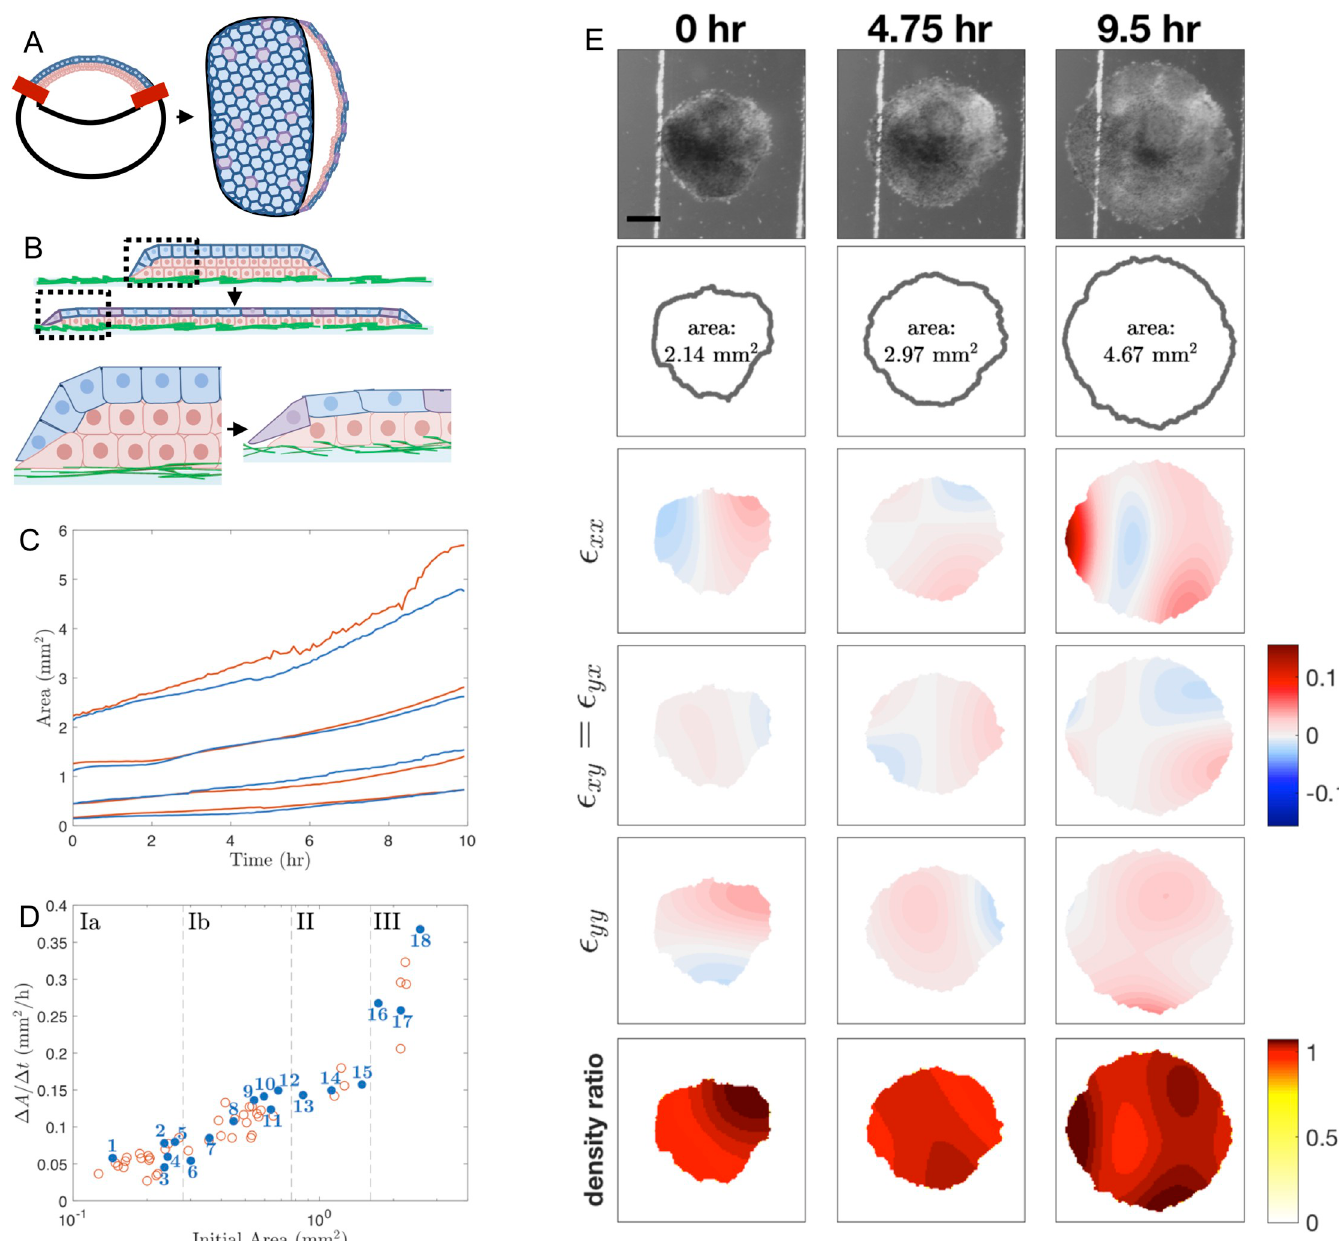
Fig 1. Schematics of experimental setup and image analysis. (A) Schematic of animal cap ectoderm of a Xenopus laevis embryo during the late blastula/mid-gastrula stage and at the tailbud stage. At the late blastula stage, a single layer of epithelial cells (blue) lay on top of multiple layers of deep mesenchymal cells (red). The ectoderm encloses the blastocoel, a fluid filled cavity in the upper half of the embryo. The red bars indicate where an animal cap explant is cut from the embryo. By the tailbud stage, the ectoderm spreads to cover the entire embryo. The mesenchymal layer undergoes intercalation to become a single layer while the cells in the epithelial layer stretch. (B) Schematic of animal cap ectoderm removed from late blastula through mid-gastrula stages and cultured on fibronectin adsorbed glass (green). As the tissue spreads, deep mesenchymal cells radially intercalate into the epithelial cell layer (purple). Dashed box region shown enlarged below. Note: Experimental images are taken from above, not from the side, so only the pigment-containing apical surface of the epithelial layer is visible. (C) Area of explants over the course of the experiment for representative explants in the model building set (blue) and test set (red). Explants shown here are the same explants analyzed in Fig 4. (D) Average change in area over 10 hours ( Δ A / Δ t ),calculated as the slope of the regression line of area measurements over time (as in panel C), for Xenopus animal cap explants of different initial sizes. The explants are grouped by initial area into subgroups Ia, Ib, II, and III, indicated by the dashed lines. The blue filled-in circles correspond with the explants included in our model building set and the red circles correspond with the explants included in our test set. (E) Time-lapse images of an explant spreading are shown in the first row, followed by the boundary identified by the Level Sets plugin. Strains defined in Eq 3 in the S1 File are shown in the third, fourth and fifth rows. Density ratios (Eq 15) are shown in the last row. See the S1 Video for time-lapse sequences of these still frames. Scale bar: 500 μ m.